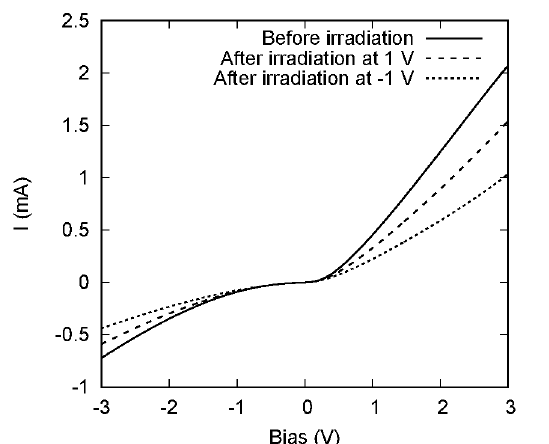
Fig. 2. Experimental I-V characteristics obtained before irradiating the device (solid line) and after irradiating the device (dashed lines). The medium dashed line corresponds to an I-V curve taken after the irradiation at 1 V and the short dashed line ta an I-V curve measured after the irradiation at -1 V.